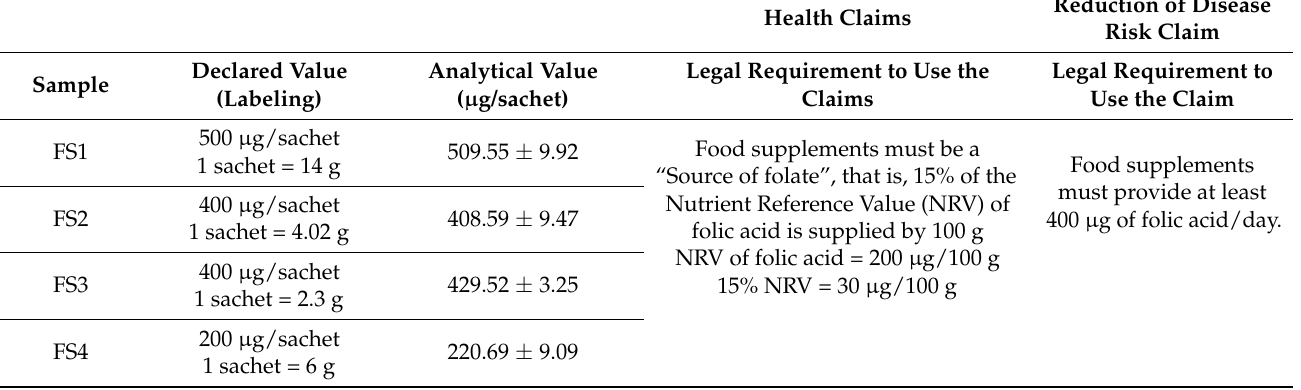
Table 5. Summary of the assessment process of health-related claims of folic acid in each sample. FS1, FS2, and FS3 samples recommended in their labeling to take 1 sachet/day (500 µ g folic acid/day for FS1 and 400 µ g folic acid/day for FS2 and FS3), whereas the FS4 sample recommended 2 sachets/day (that is, 400 µ g folic acid/day); all food supplements met the legal requirement established in the European